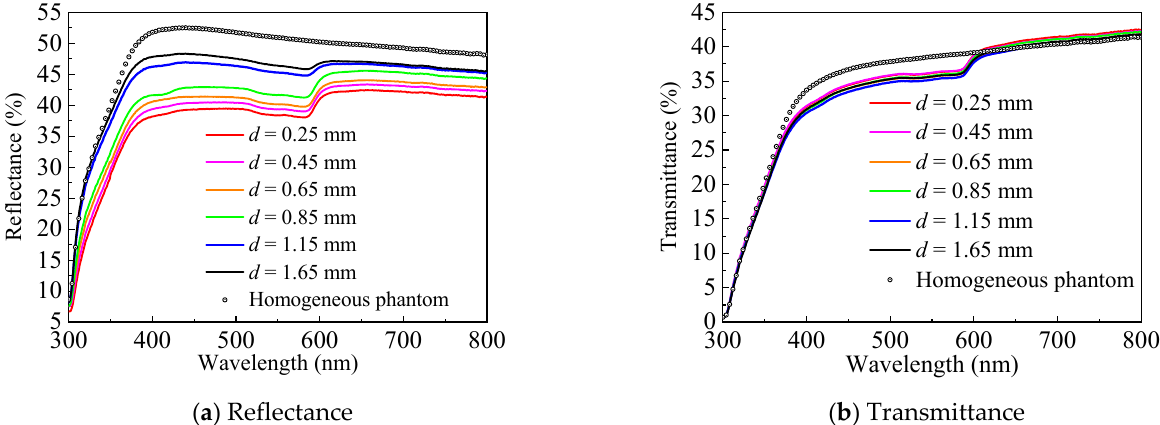
Figure 12. Vessel depth-related spectral signal.